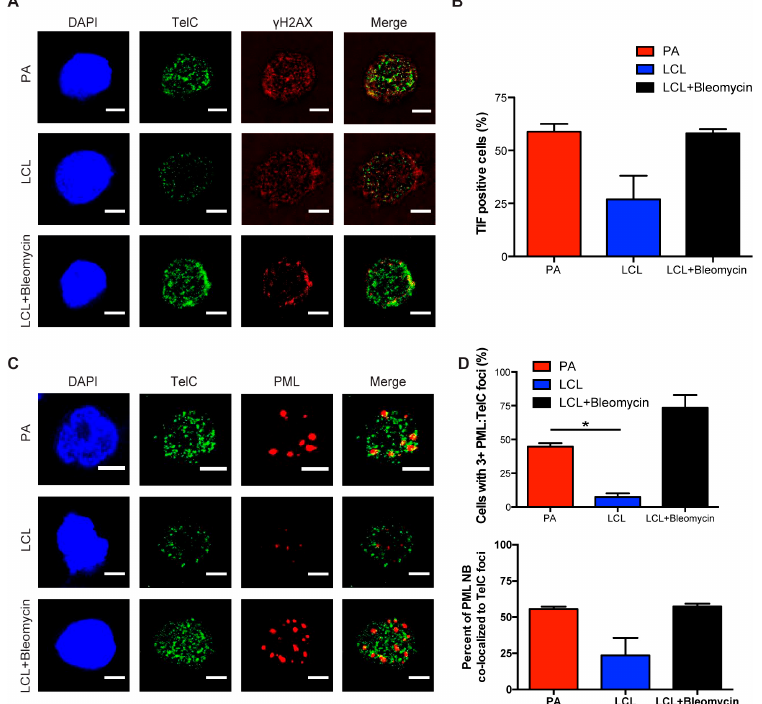
Figure 2. Persistent DNA damage localizes to telomeres in arrested EBV-infected B cells. ( A ) IF-telomere FISH of γ H2AX (red), TelC (green), and DAPI (blue) measured from sorted arrested B cells, LCLs, and bleomycin-treated LCLs. Co-localization of γ H2AX-TelC is shown in Merge. ( B ) Quantification of TIF positive cells as defined by the co-localization of TelC with γ H2AX from ( A ). ( C ) IF-telomere FISH of PML NBs (red), TelC (green), and DAPI (blue) measured from sorted arrested B cells, LCLs, and bleomycin-treated LCLs. Co-localization of PML-TelC is shown in Merge. ( D ) Upper, quantification of cells with greater than three PML NBs co-localized with TelC per nucleus from ( C ). Lower, quantification of the percentage of PML NBs co-localized to TelC foci per cell. Error bars represent S.E.M of three independent donors. * p < 0.05 as determined by a Student’s t test. For lower graph, PA vs. LCL p = 0.0576. All scale bars indicate 5 µm.